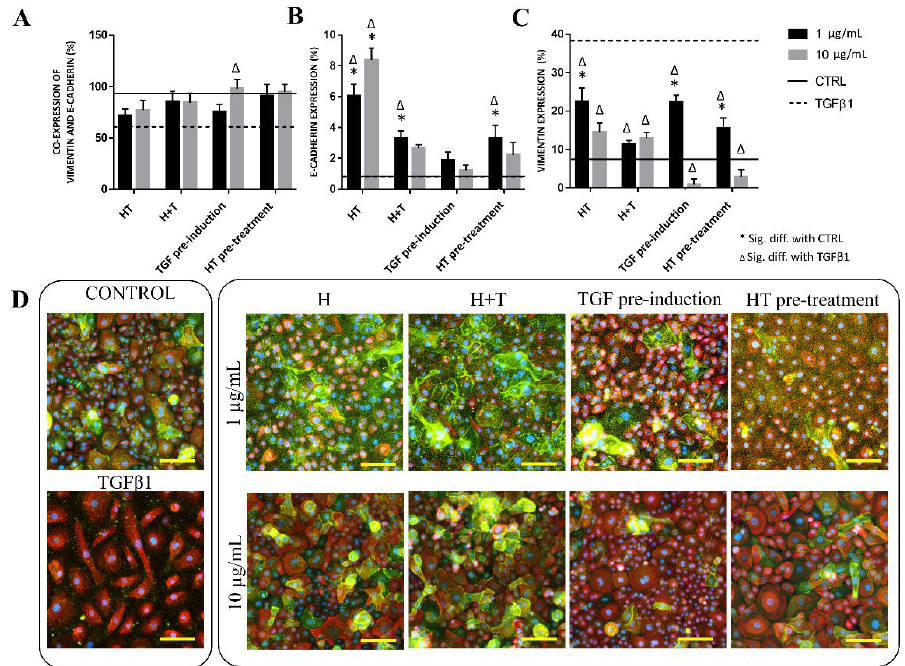
Figure 3. Protein expression levels of TGFβ1 - and HT-treated RECs. ( A ) E-cadherin and vimentin co-expression levels (%) vs. control. ( B ) E-cadherin expression (%) vs. control. ( C ) Vimentin expression (%) vs. control. * p < 0.05: significantly different from control. # p < 0.05: significantly different from Group T (Supplementary Material Table S3). ( D ) Immunostaining of vimentin and E-cadherin expression levels at 72 h. Green cytoplasm indicates E-cadherin expression level, red indicates vimentin, and blue is DAPI-stained nuclei. Scale bar represent 100 µm.